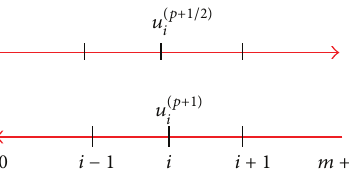
Figure 1: The two-stage IADEMF4 algorithm. The directions of the sweeps at the (𝑝 + 1/2) and (𝑝 + 1) iteration levels.